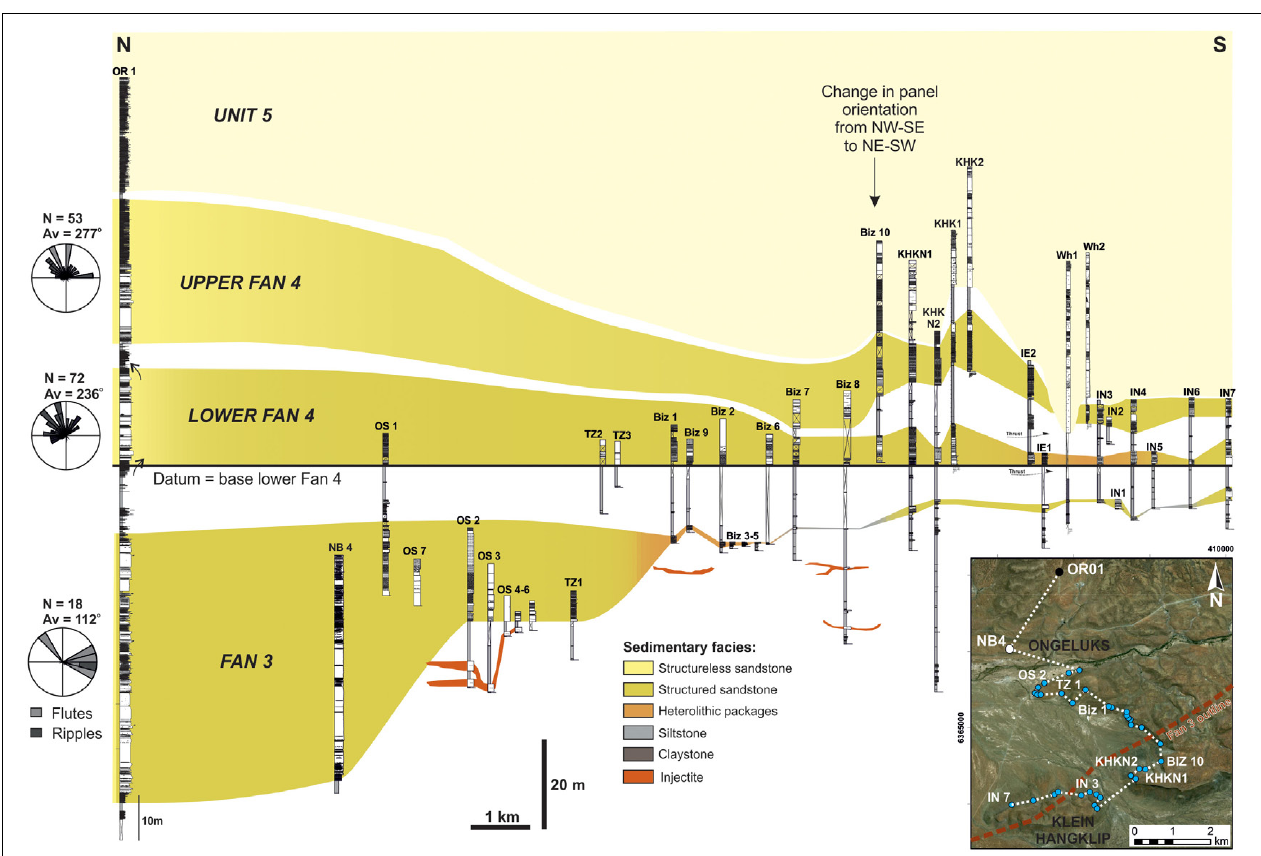
FIGURE 8 | Oblique up-dip pinchout of Fans 3 and 4 around the Klein Hangklip and Droogekloof area (flattened at the base of lower Fan 4). Fan 3 decreases in thickness abruptly between Ongeluks and Klein Hangklip, beyond which cm- to m-scale deposits are exposed until Groot Hangklip. The location of several injectites below Fan 3 is shown. Lower and upper Fan 4 also decrease in thickness toward the south but at a much slower rate compared to Fan 3. For context, the basal part of Unit 5 is also shown. Note that Unit 5 erodes into upper Fan 4 at Klein Hangklip. The correlation is color coded according to the observed sedimentary